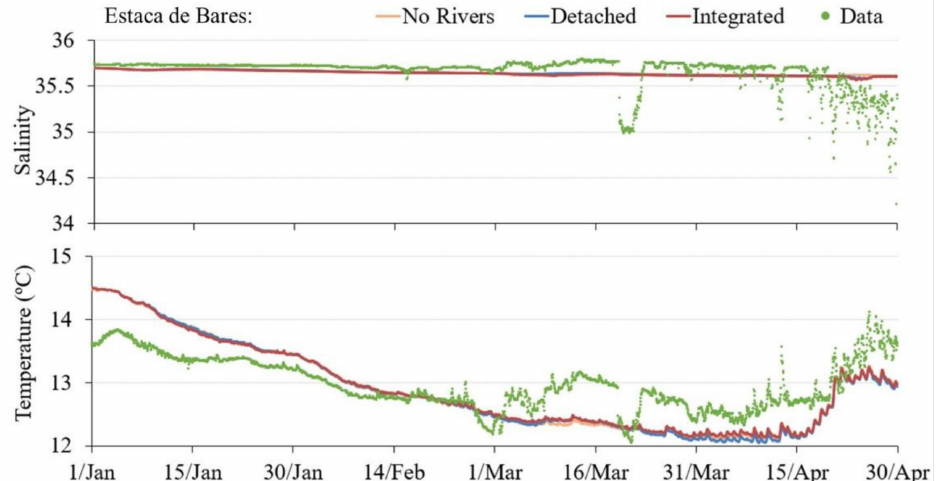
Figure 5. Salinity and temperature time series produced by the three PCOMS implementations and the Estaca de Bares in situ moored buoy during the period between 1 January and 1 May